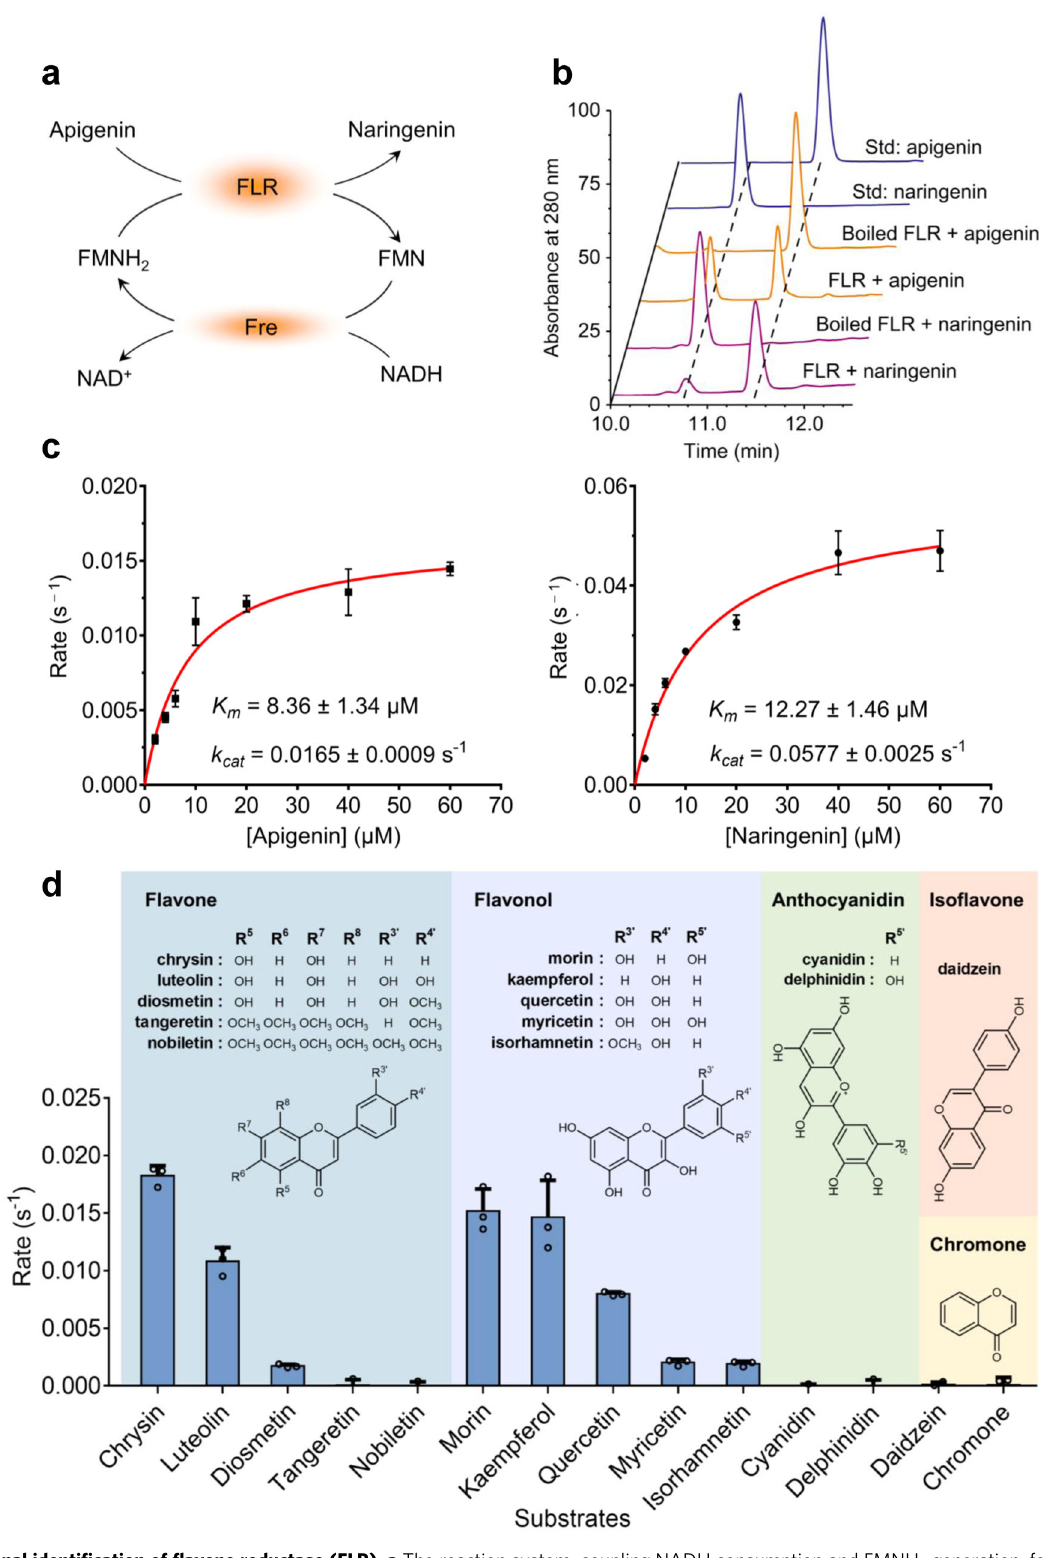
Fig. 2 Functional identi fi cation of fl avone reductase (FLR). a The reaction system, coupling NADH consumption and FMNH 2 generation, for the assay of FLR activity towards apigenin. Fre, NADH-speci fi c FMN oxidoreductase. b HPLC analysis of the products formed by the in vitro FLR-catalyzed conversion between apigenin (Api) and naringenin (Nar). The control reactions were carried out using the disabled FLR (boiled). c In vitro steady-state kinetic analysis of FLR using apigenin or naringenin as the substrate. Each data point represents mean ± SD ( n = 3). Error bars show SDs. d A screening of the substrate spectrum of FLR. Initial turnover rates of puri fi ed FLR towards different substrates (100 μ M) were measured. Data are represented as mean ± SD ( n = 3). Error bars show